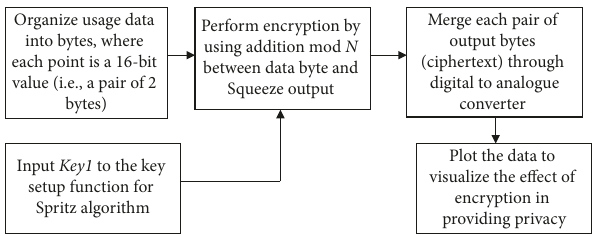
Figure 7: Applying Spritz to electrical usage